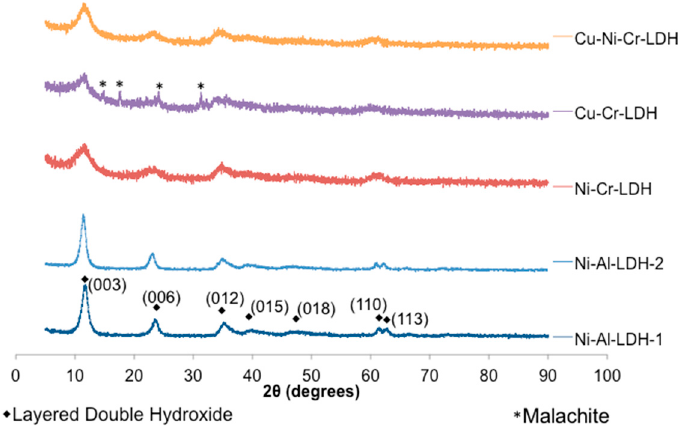
Figure 1. X ‐ ray diffraction (XRD) analysis of synthesized LDH catalysts. Figure 1. X-ray diffraction (XRD) analysis of synthesized LDH